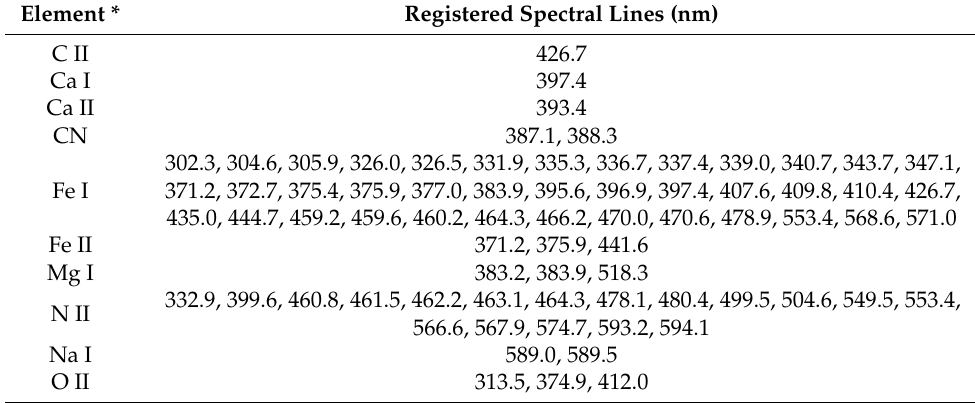
Table 2. Emission lines of rice